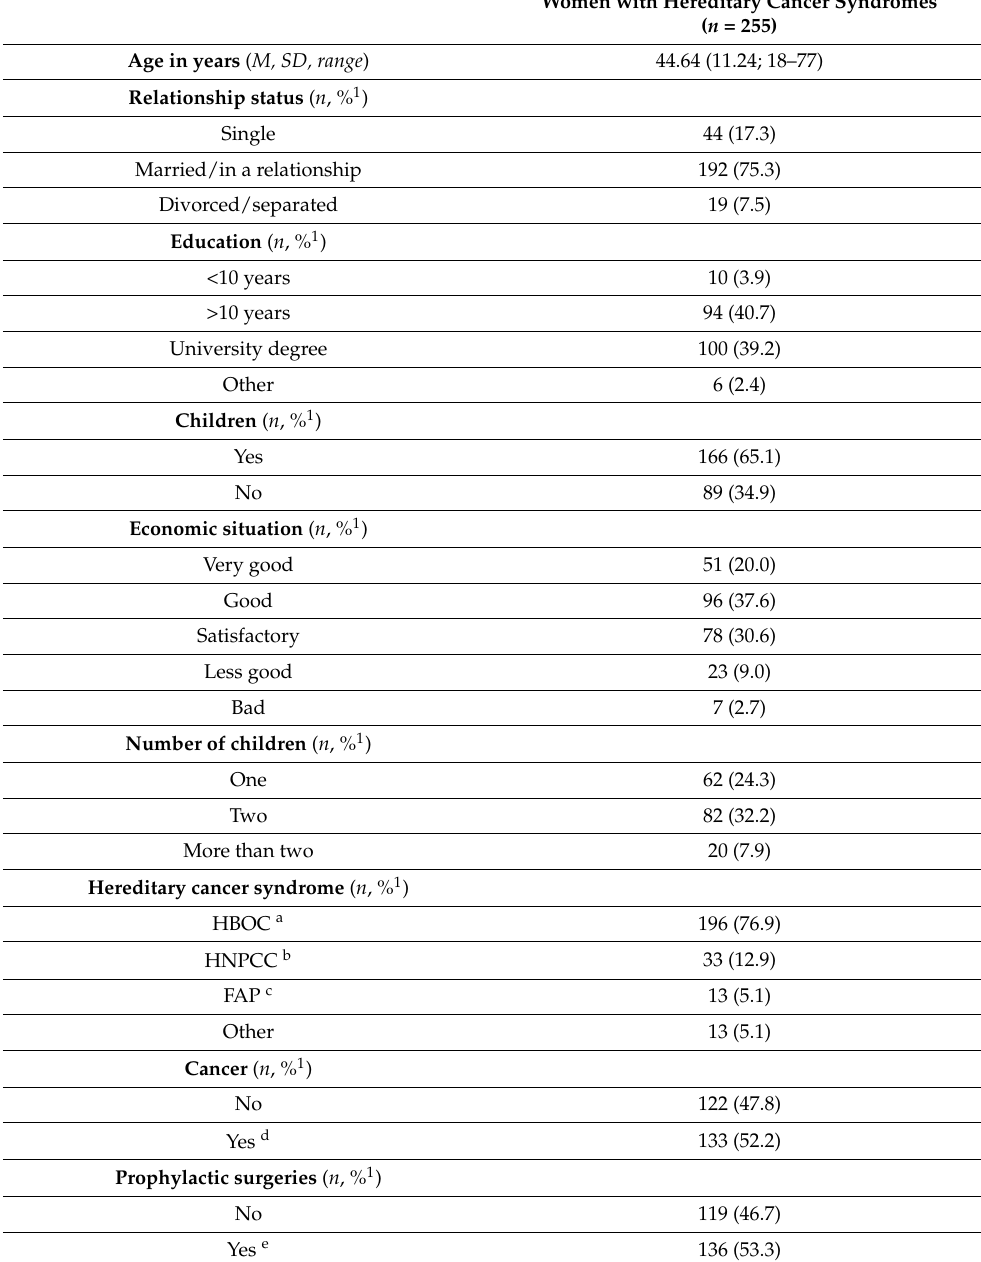
Table 1. Demographic characteristics of the